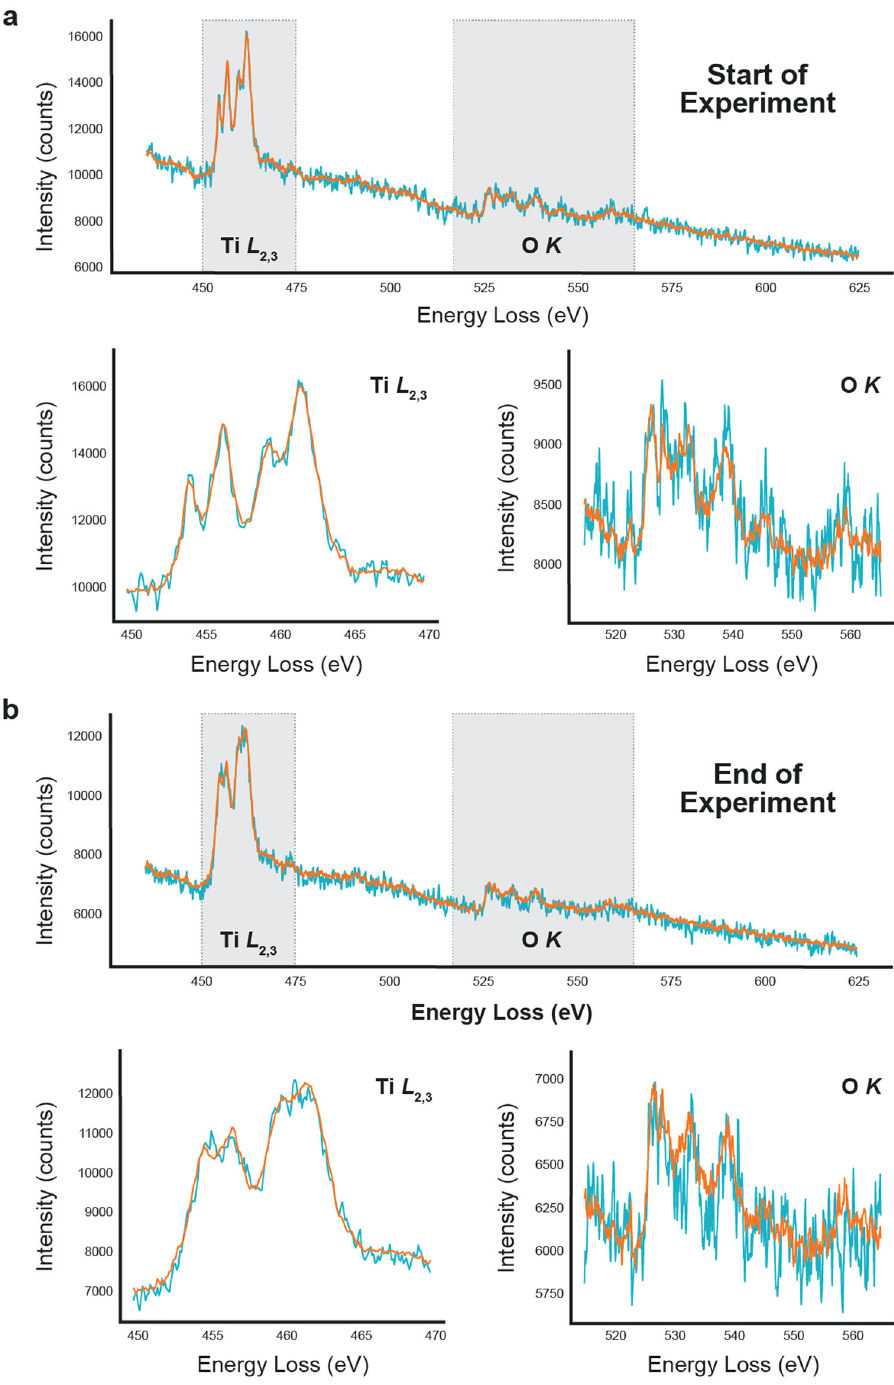
Fig. 4 Optimized LSTM prediction of an STO order-disorder phase transition. a Timestep near the start of the experiment ( t ≈ 15 s), where the sample is crystalline and nearly fully oxidized. b Timestep near the end of an experiment ( t ≈ 60 s), where the sample is largely amorphous and heavily reduced. The blue line indicates the real spectrum at an 8 timestep horizon, while the orange indicates the LSTM model output. Shaded regions of each full spectrum indicate the Ti L 2,3 and O K